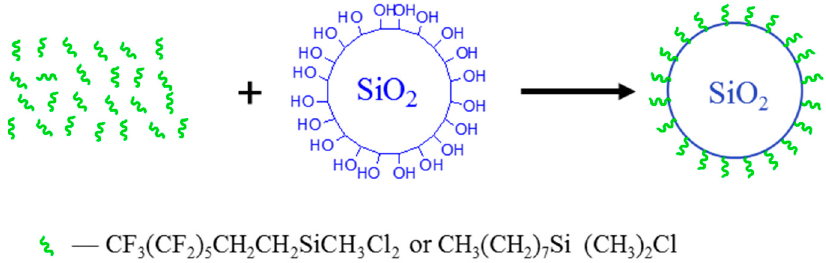
Figure 4. Schematic diagram of the functionalization of the colloidal particle.